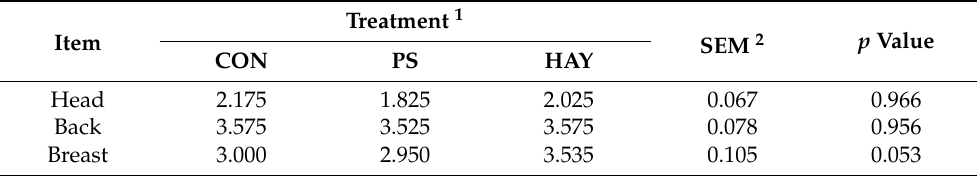
Table 5. Means of feather scores of each part of laying hens’ body according to environmental enrichment